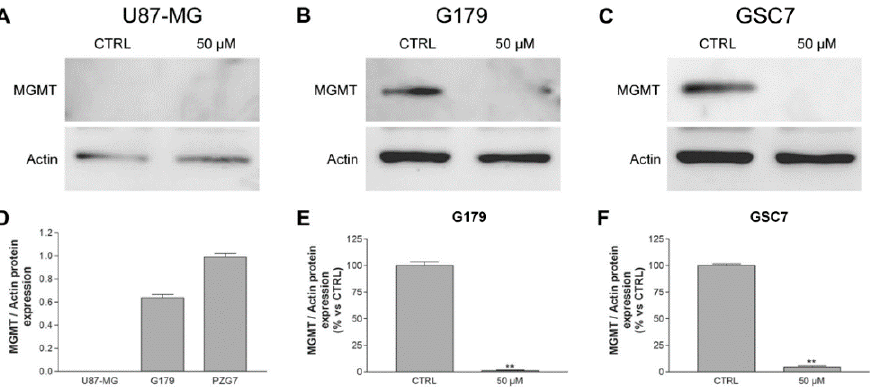
Figure 6. Representative images and quantification graphs of Western blots of MGMT in U87-MG ( A ), G179 ( B , E ), and GSC7 ( C , F ) cells, treated with MV1035 50 µM or not treated (CTRL) for 24 h. ( D ) Comparison of MGMT expression in untreated cells. Data are represented as the mean ± SD compared to untreated controls, arbitrarily set to 100%. ** p < 0.01 vs. CTRL.